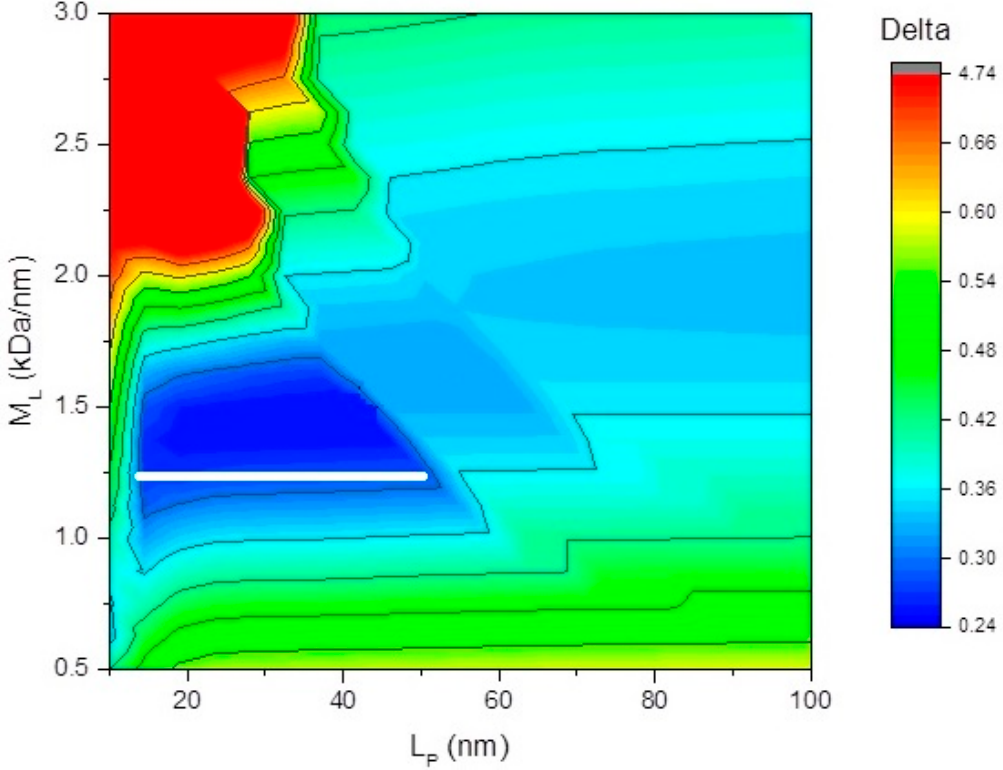
Figure 5. HYDFIT estimates of the persistence length, L p , based on the combined intrinsic viscosity, sedimentation coefficient, and molecular weight data of the three fractions. Because of the small number of data points, only a range of possible values could be specified, indicated by the white bar. The assumption is also made that the fractions have approximately the same conformation.